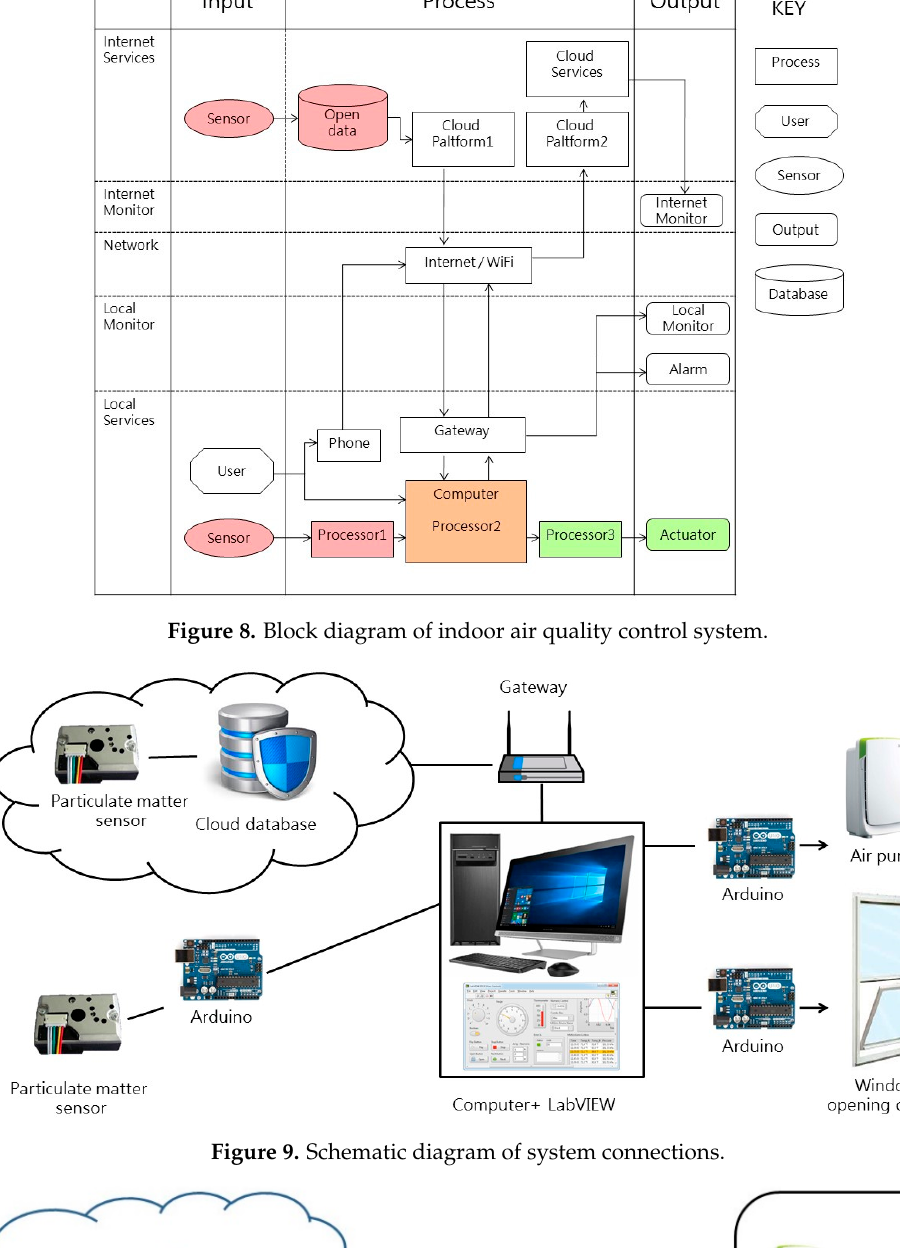
Figure 7. Schematic diagram of the environment. Our indoor air quality control system based on intelligent agent theory is composed of three parts, namely the input end (sensing), processing end (calculation), and output and (action) (Figure 8), which are described as follows: